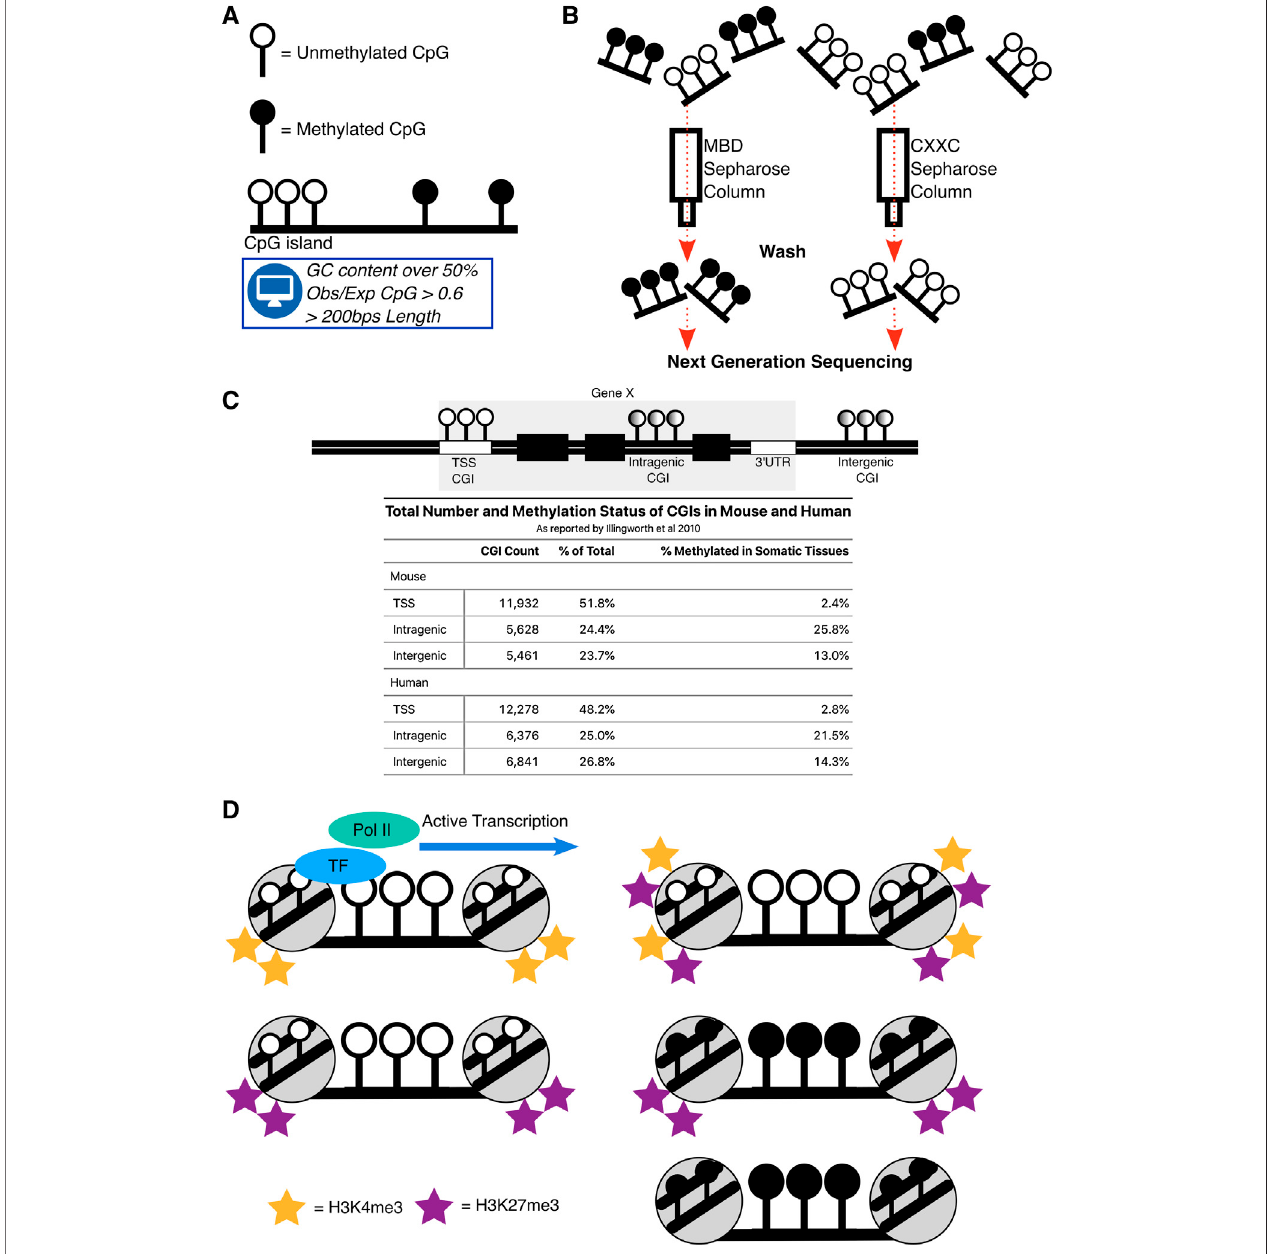
FIGURE1| De fi nitionsandstatesofCpGislands. (A) DepictionofthetypicalCpGsinthemammaliangenomewhichareDNAmethylatedinisolationbutaredevoid of this mark in the CGI context. CGIs were originally de fi ned bioinformatically. (B) Schematic demonstrating CGIs locations were biochemically determined. MBD and CXXCproteins fi xedtoaSepharosecolumnallowedpuri fi cationofDNAmethylatedandunmethylatedCGIsinmammals. (C) RepresentationofCGIsacrossmammalian genomes and a table, summarising the proportion and methylation status of CGIs as reported by Illingworth et al. (2010) in mouse and human across TSS, IntragenicandIntergenicregions.TotalCGInumbersinmouse=23,021,human=25,495 (D) SummaryofthemainstatesofCGIsacrossthegenome.Theiractivestate is associated with binding of transcription factors (TF) and subsequent RNA Polymerase II (Pol II) binding. Repressed states of CGIs are through combinations of DNA methylation, H3K4me3 and